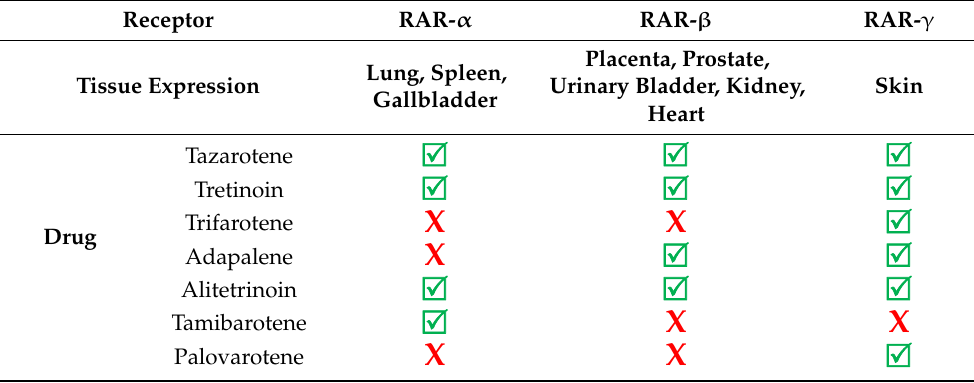
Table 1. The table shows the different drugs capable of interacting with the different RAR isoforms. Of all the drugs reported, only trifarotene and palovarotene are selective for RAR- γ . Currently, palovarotene is used in the treatment of progressive ossifying fibrodysplasia, while trifarotene is used in lamellar ichthyosis and acne. The importance of receptor selectivity is confirmed by the reduction of adverse effects due to the action on the other